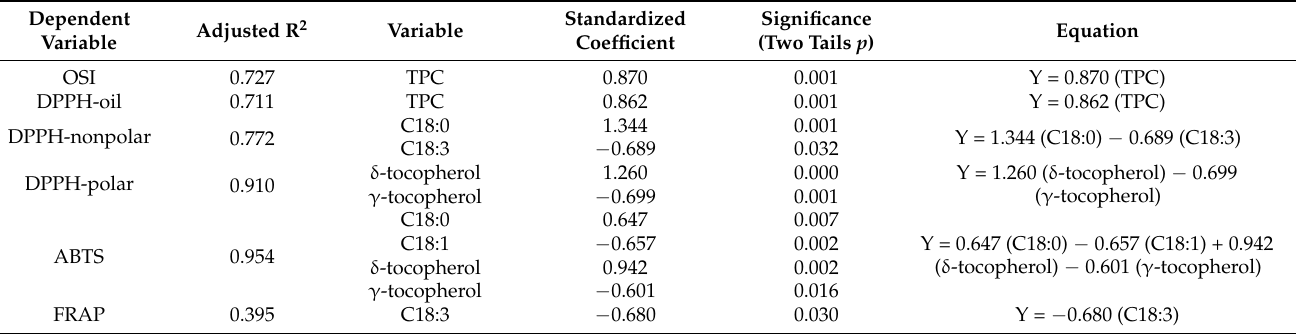
Table 4. Equations, variables and regression coefficients in the prediction of antioxidant capacity by multiple linear